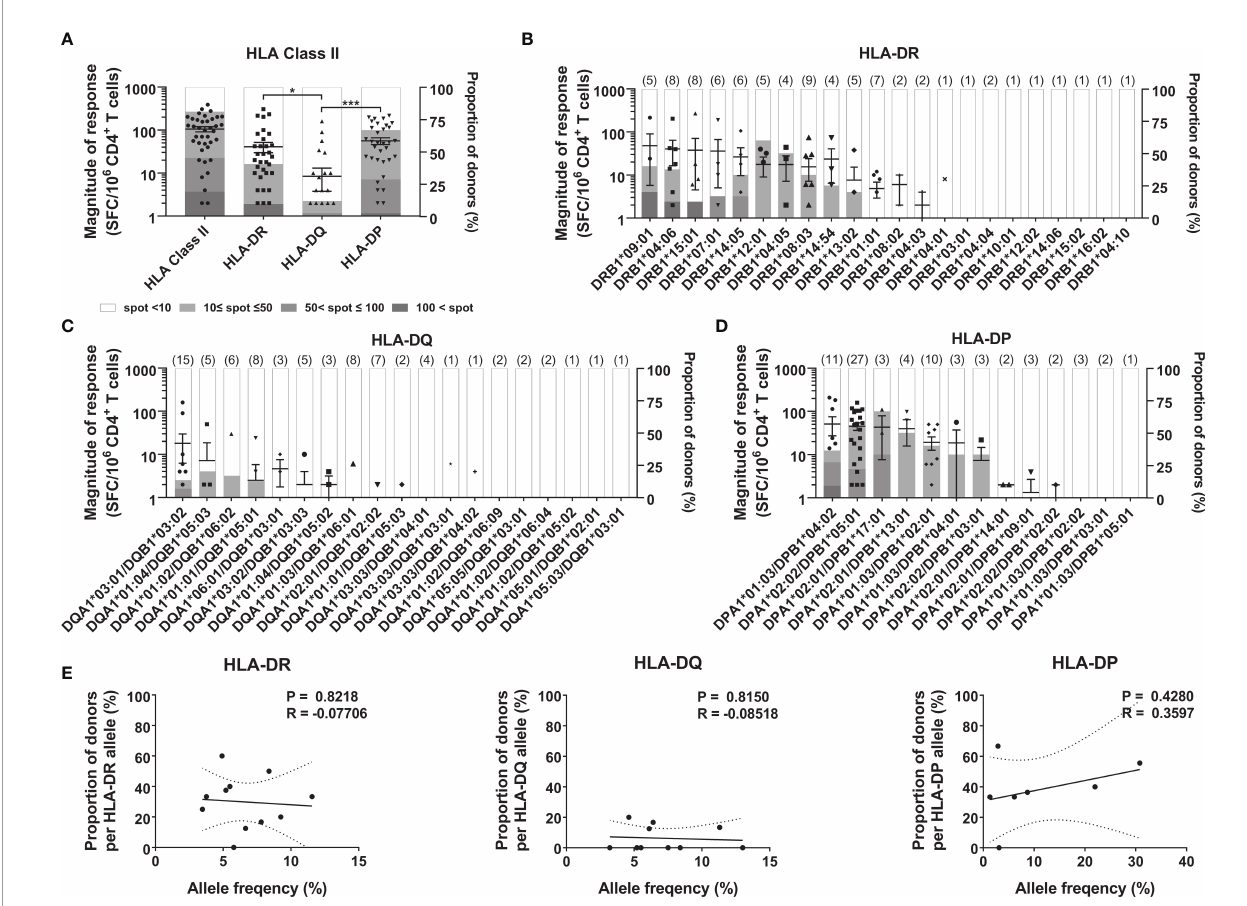
FIGURE 1 | CD4 + T cell responses to SARS-CoV-2 antigens according to HLA class II loci and alleles. CD4 + T cells were stimulated with an allotype-matched aAPCs pulsed with a mixture of peptide pools of spike, nucleocapsid, and membrane protein. The responses by HLA-DR, -DQ, and -DP loci (A) , and HLA-DR alleles (B) , HLA-DQ alleles (C) , and HLA-DP alleles (D) in 42 donors were compared. Each dot presents the magnitude of response by a locus or an allele in an individual. Error bars indicate the mean ± standard error of the mean (SEM), and the number of donors with the allele are shown in parentheses. The stacked bar graph presents a proportion of the classi fi ed response in donors out of the donors with the allele. Statistical analysis was performed using a one-way ANOVA. *P < 0.05, ***P < 0.001. (E) Correlation of allele frequency with the proportion of positive response by HLA-DR, -DQ, and -DP alleles that are in at least three individuals. Statistical analysis was performed using Pearson ’ s correlation analysis. A line of best fi t (solid lines) and the 95% con fi dence bands (dotted lines) were analyzed using linear regression